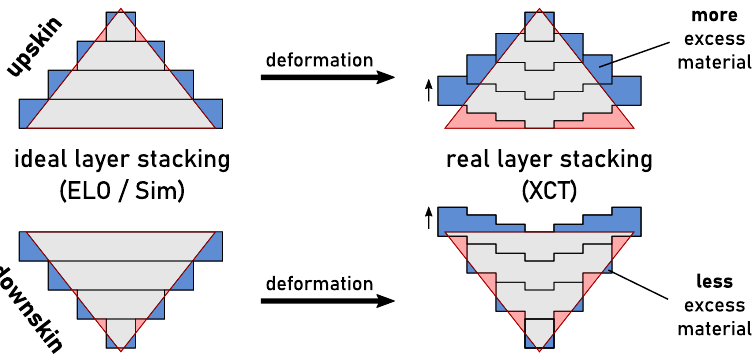
Figure 4. Schematic effect of surface orientation on the accuracy of a part due to an assumed layer deformation induced by thermal